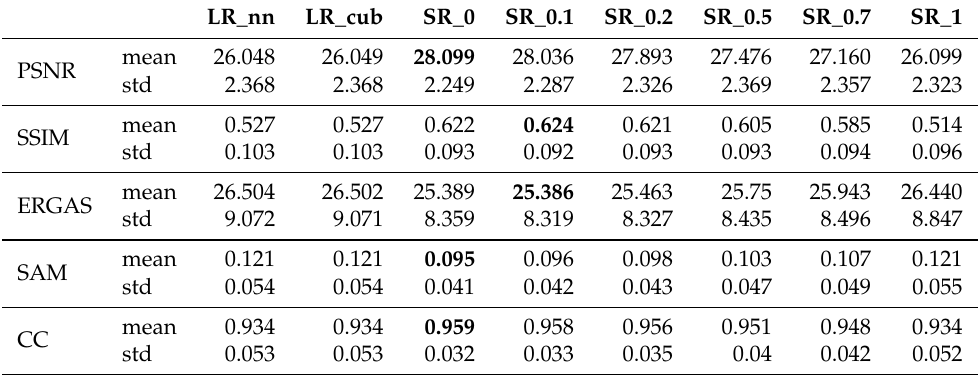
Table 4. Quality metrics results on the W-S Set1 for nearest neighbor (LR_nn) and bicubic (LR_cub) interpolation and our method SR_ α for different values of α